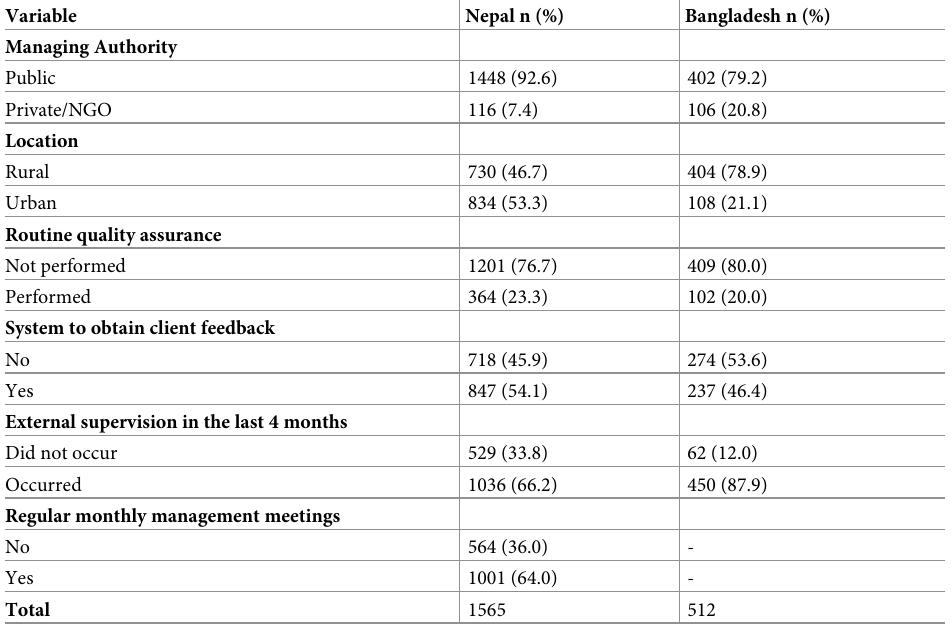
Table 3. Characteristics of health facilities according to covariates.